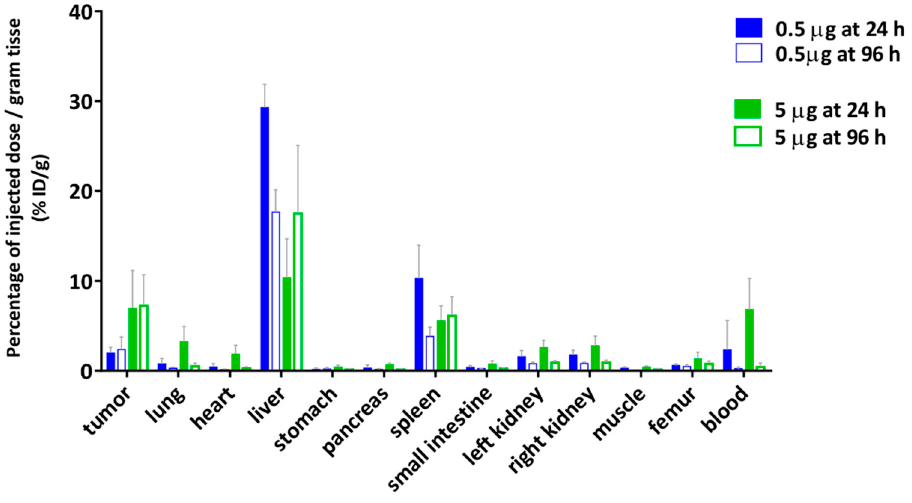
Figure 8. Biodistribution of [ 177 Lu]DOTA(SCN)-cG250 from conjugate C7 using a 0.5 µ g (2 MBq) and a 5 µ g (18 MBq) protein dose per animal ( n = 4).